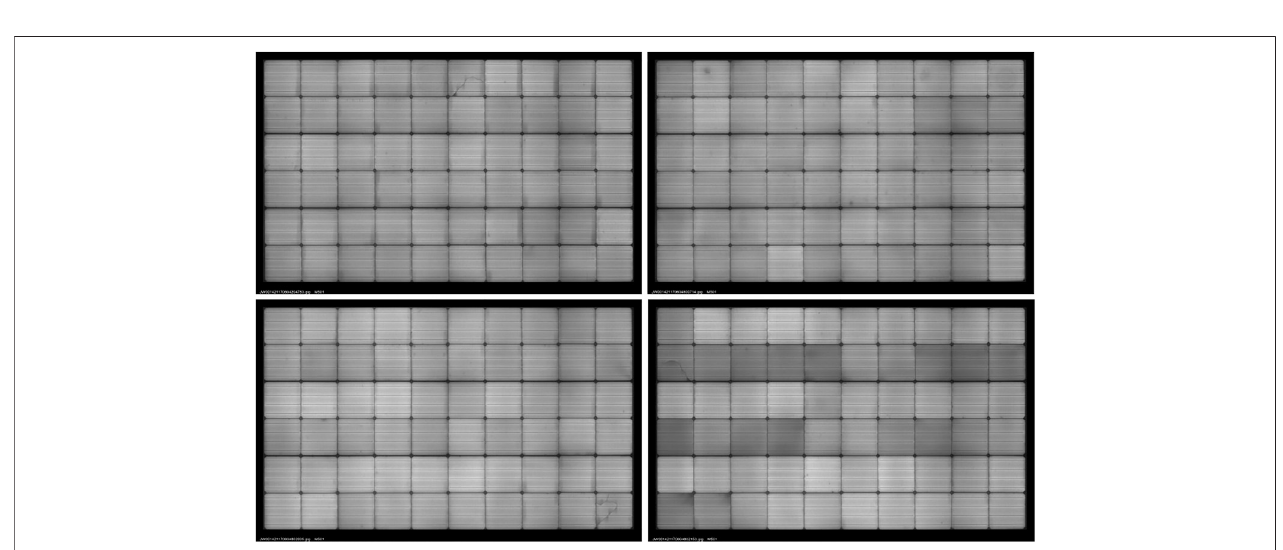
FIGURE 7 | Original image of solar